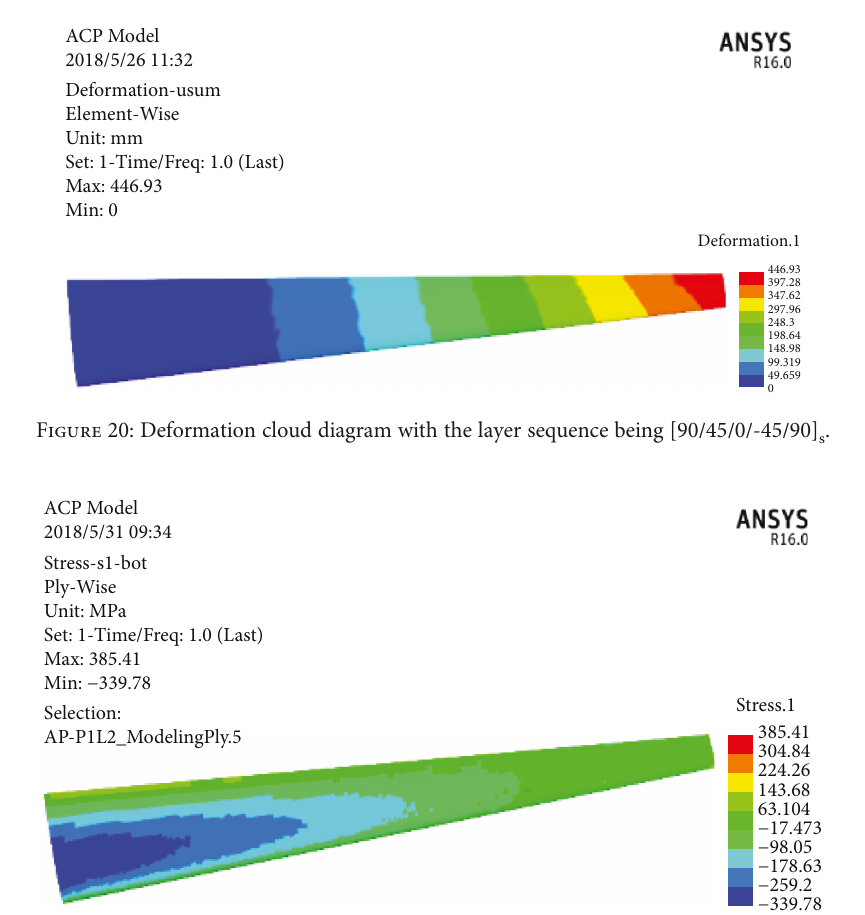
Figure 21: Stress cloud diagram of the upper wing with the layer sequence being [90/45/0/-45/90]